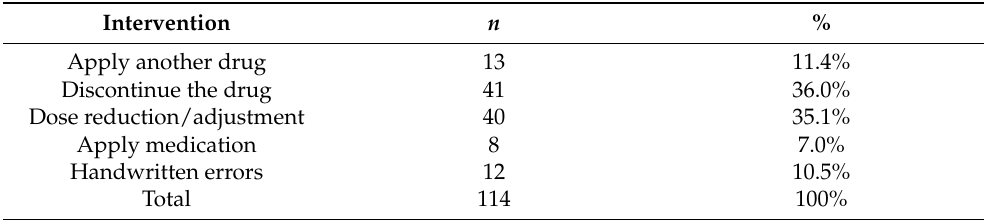
Table 3. Interventions of the clinical pharmacist observed by the ward physician in the therapy of patients with vascular diseases.